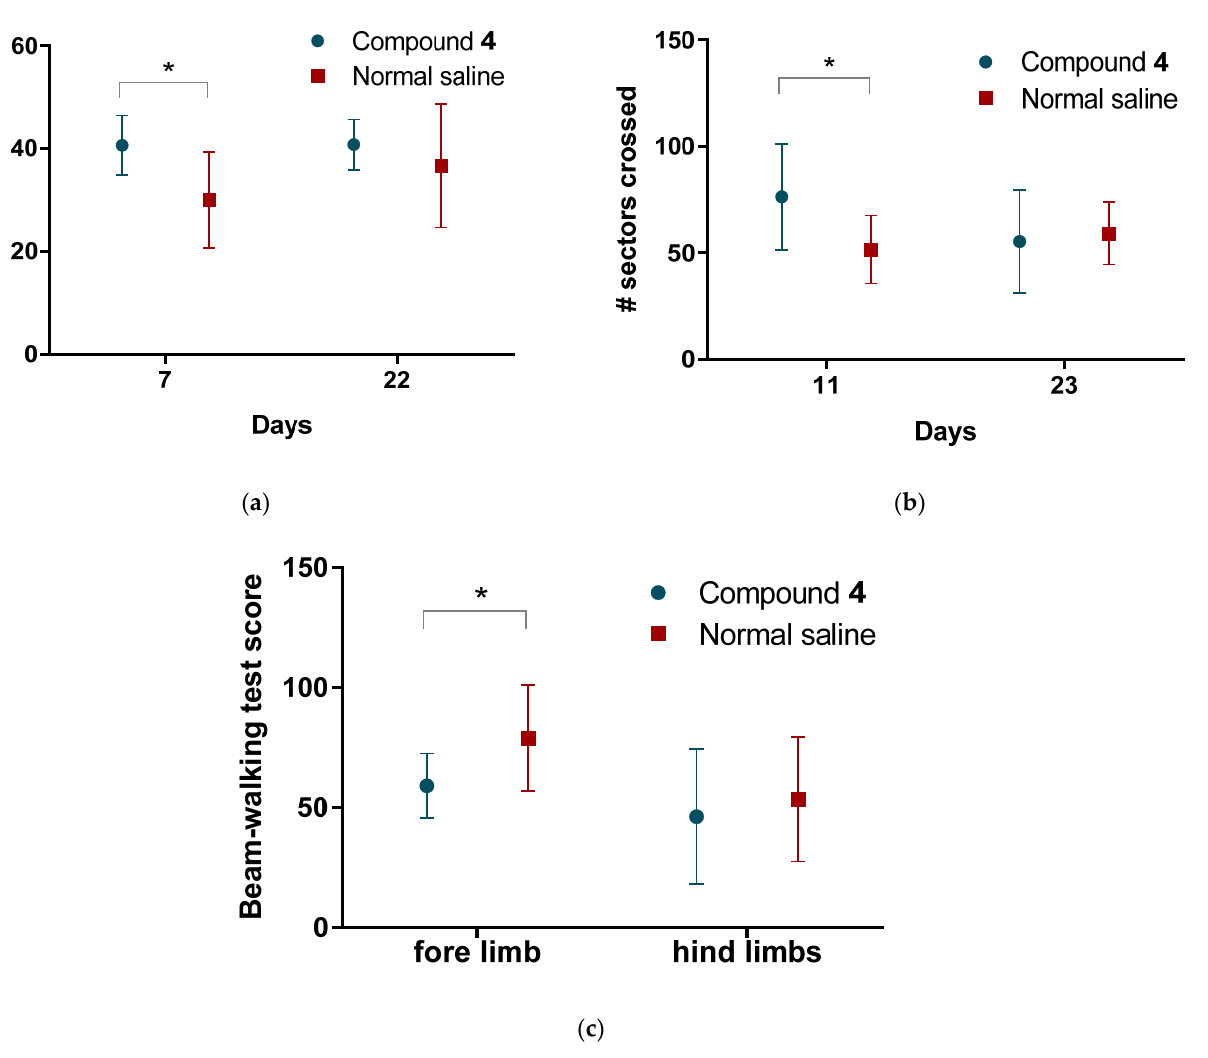
Figure 6. Results of the behavior tests ( a )—Hole-board test, the average number of sectors crossed; ( b )—Open field test, the average number of sectors crossed ( c ) beam-walking test scores. Compound 4 —green. Normal saline—red. Data are presented as mean and SD. ANOVA was used for significance calculation, * p <